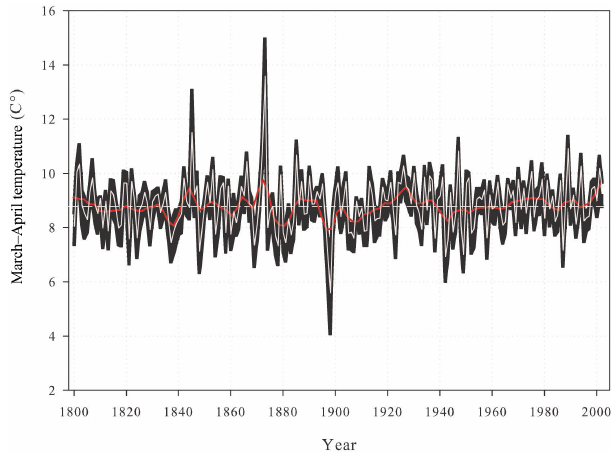
Figure 6. March–April temperature reconstruction for Turkey for the period 1800–2002CE. The horizontal, central white line shows the reconstructed long-term mean and does not include instrumen- tal data; black background denotes Monte Carlo ( n = 1000) boot- strapped 95% confidence limits; and the red line shows 13-year low-pass filter values.